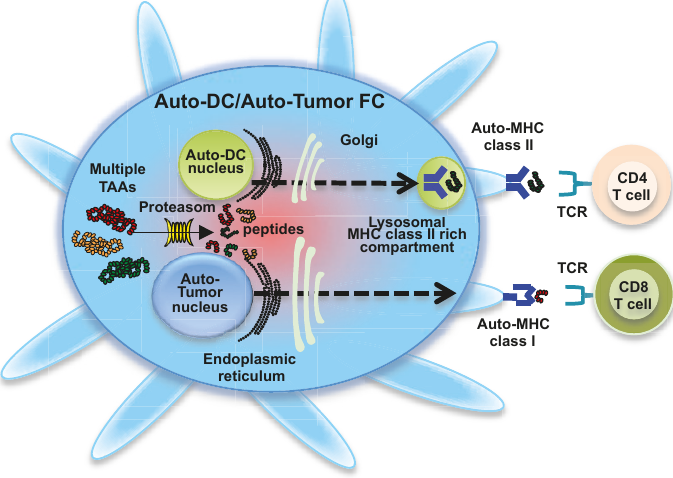
Figure 1. Fusion cells generated with dendritic cells and whole tumor cells. Fusions of dendritic cells (DCs) and whole tumor cells (DC-tumor FCs) display a characteristic phenotype comprised of major histocompatibility complex (MHC) class I molecules, MHC class II molecules, co-stimulatory molecules (CD80 and CD86), and multiple tumor-associated antigens. Multiple tumor-associated antigens from whole tumor cells are degraded by proteasome in DC-tumor FCs (solid line arrow), and antigenic peptides are loaded onto MHC class I molecules in the endoplasmic reticulum. The peptide-MHC class I complexes are then expressed on the DC-tumor FC surface (dash line arrow) and stimulate polyclonal antigen-specific CD8 + T cells. DC-tumor FCs can also synthesize MHC class II-restricted antigenic peptides in the endoplasmic reticulum. These are transported to the cytoplasm, where peptide-MHC class II complexes are generated (dash line arrow). Peptide-MHC class II complexes are also expressed on the DC-tumor FC surface and activate polyclonal antigen-specific CD4 + T